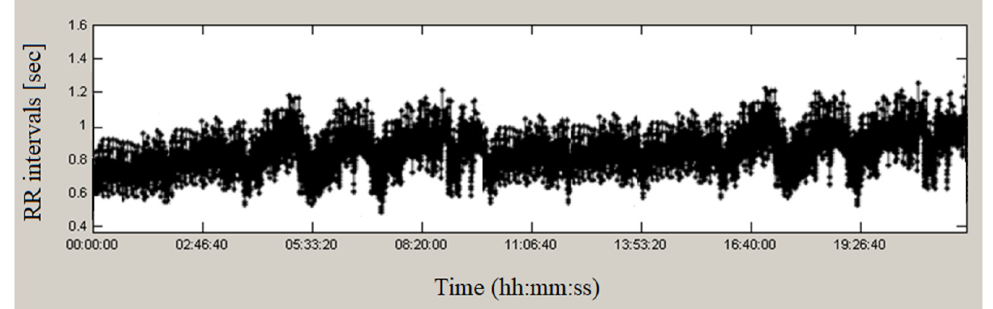
Figure 5. RR intervals of heart failure.